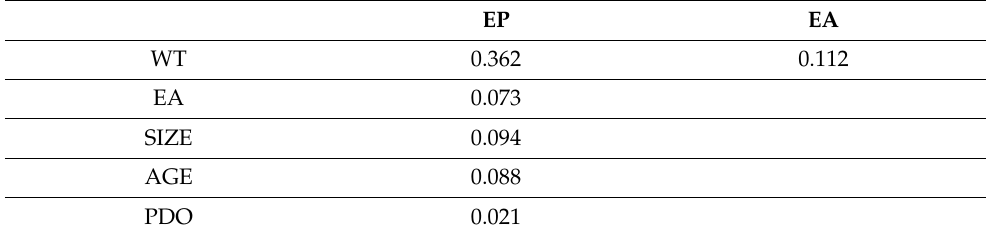
Table 7. Effect sizes (f 2 ) of the analyzed variables.